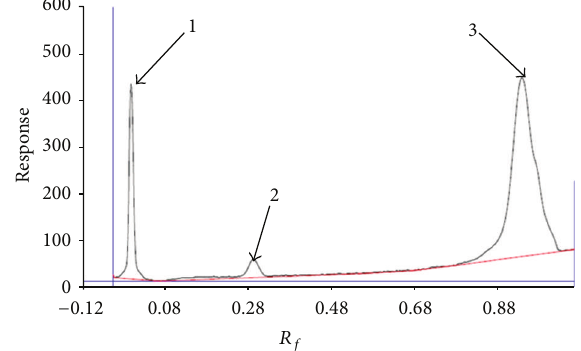
Figure 2: Chromatography of lipids in solvent system containing chloroform, diethyl ether (9:1, v/v) scanned at 254 nm using Camag HPTLC scanner.